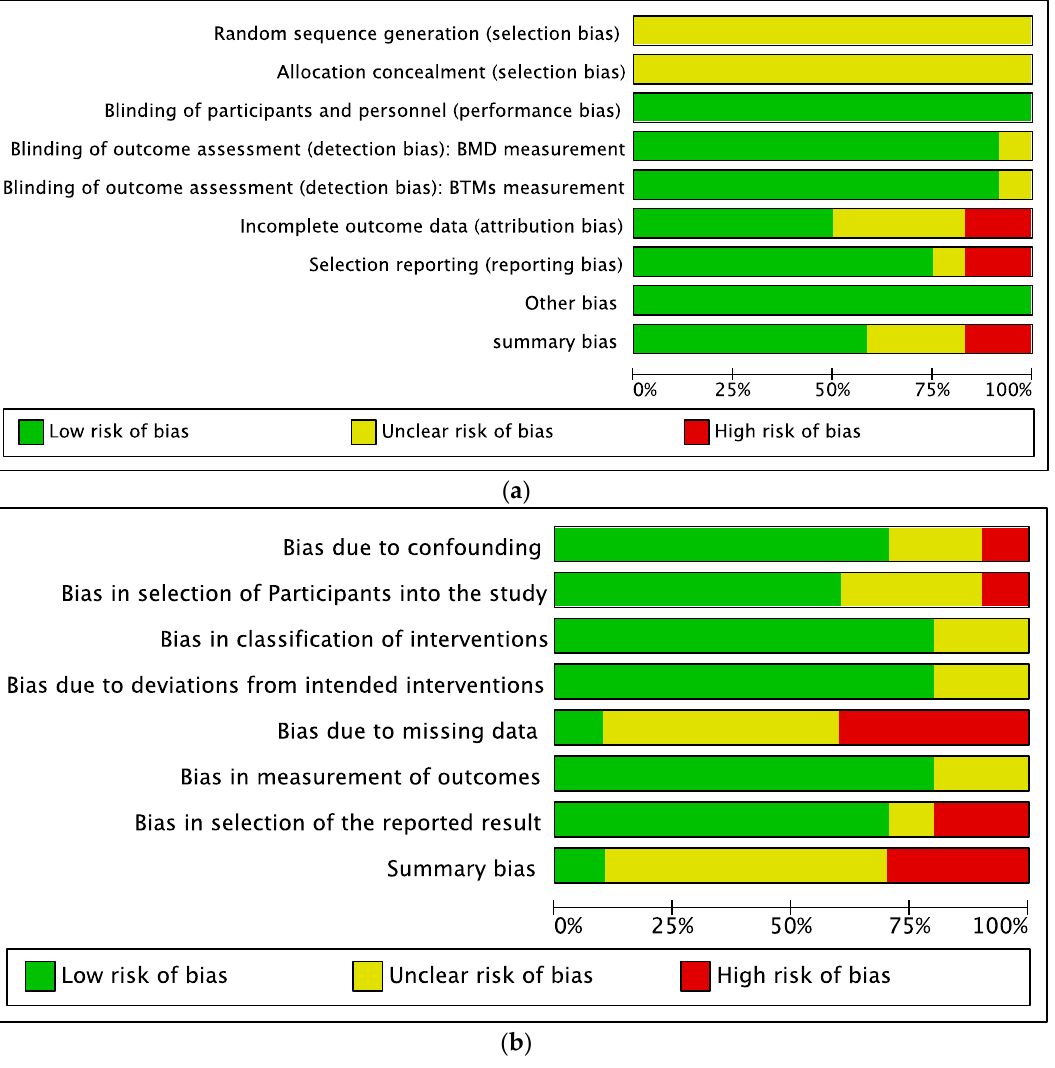
Figure 2. Quality assessment of the eligible studies. ( a ) Summary of the quality of the randomized controlled trials; ( b ) Summary of the quality of the nonrandomized trials.